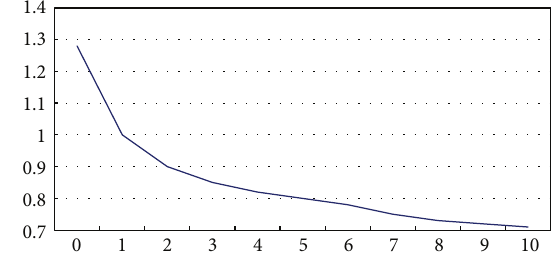
Figure 4: The attenuation curve of interest